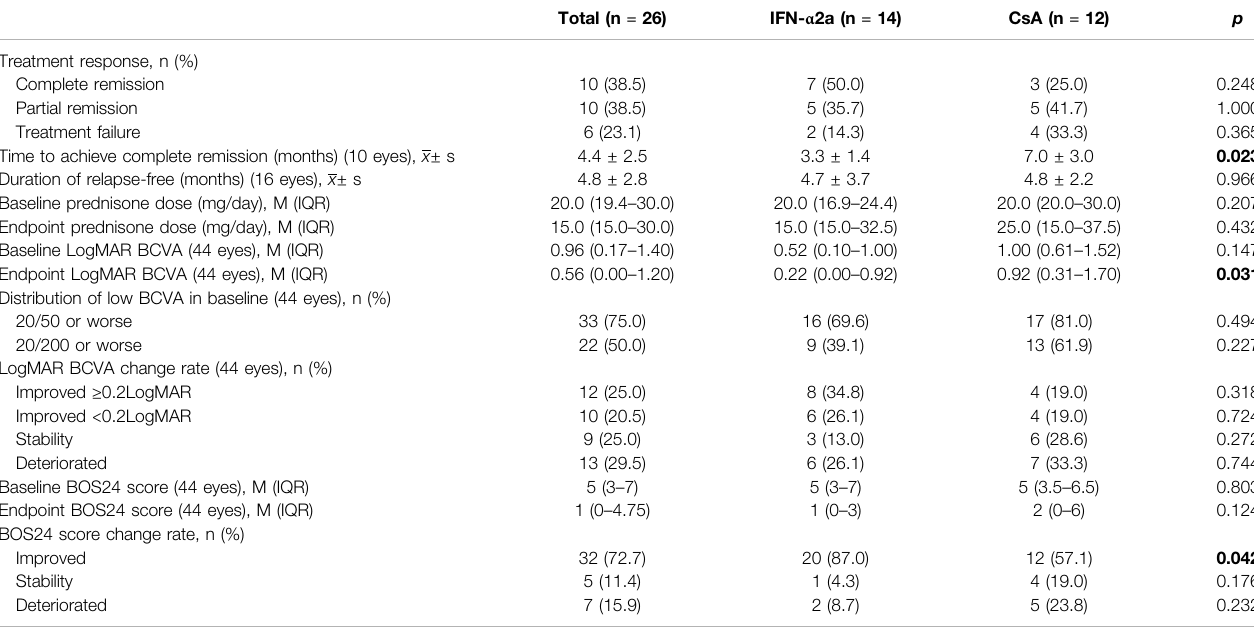
TABLE 2 | Ef fi cacy outcomes of the 26 refractory BU patients treated with IFN- α 2a and